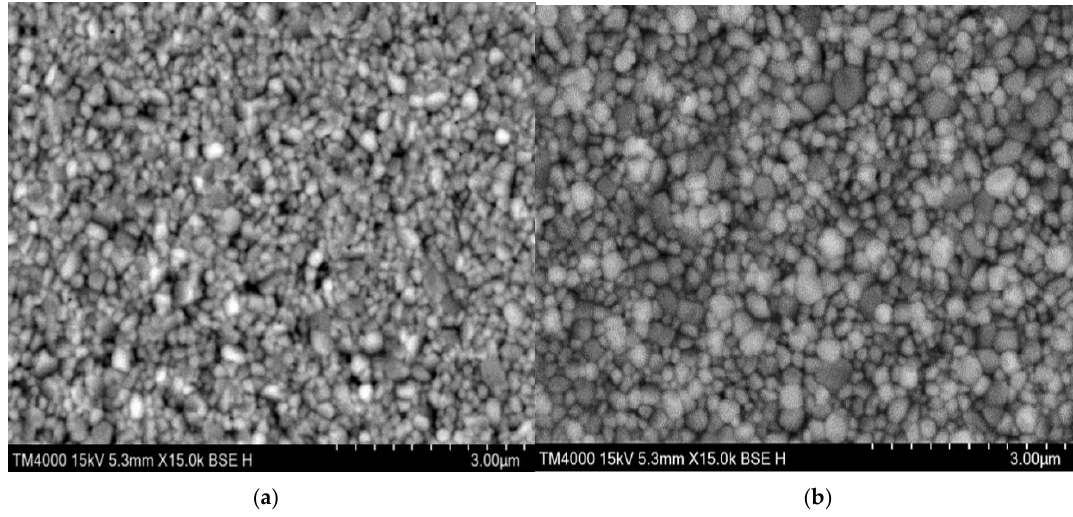
Figure 2. ( a ) SEM image of CsPbBr 2.5 I 0.5 film without PAN; ( b ) SEM image of CsPbBr 2.5 I 0.5 film with PAN.